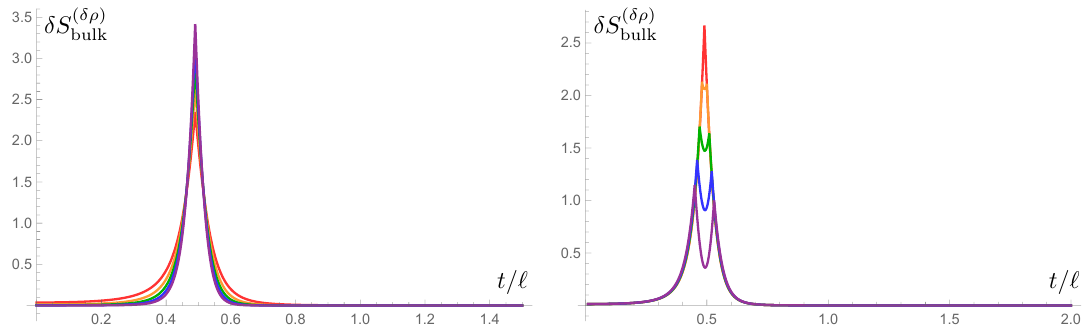
Figure 12 . Time evolution of the bulk entanglement entropy contribution at linear order in the perturbation, (cid:14)S ( (cid:14)(cid:26) ) , for cases that satisfy the condition (4.88). The latter condition is imposed such that the particle is initially inside the entanglement wedge so for a Rindler observer the state can be viewed as a local perturbation of a black brane geometry. In the left panel we have plotted the case of centered intervals, so we have set x c = 0, and we have varied (cid:1) = 3 = 2 ; 2 ; 5 = 2 ; 3 ; 7 = 2, corresponding to the red, orange, green, blue and purple curves, respectively. In the right panel we have plotted the case of non-centered intervals, specializing to (cid:1) = 2 and varying x c =‘ = 0 ; 10 (cid:0) 1 ; 2 (cid:2) 10 (cid:0) 1 ; 3 (cid:2) 10 (cid:0) 1 ; 4 (cid:2) 10 (cid:0) 1 , corresponding to the red, orange, green, blue and purple curves, respectively. For concreteness we have (cid:12)xed (cid:11)=‘ = 10 (cid:0) 1 in all the plots and, accordingly, chosen values for x c =‘ such that (4.88) is